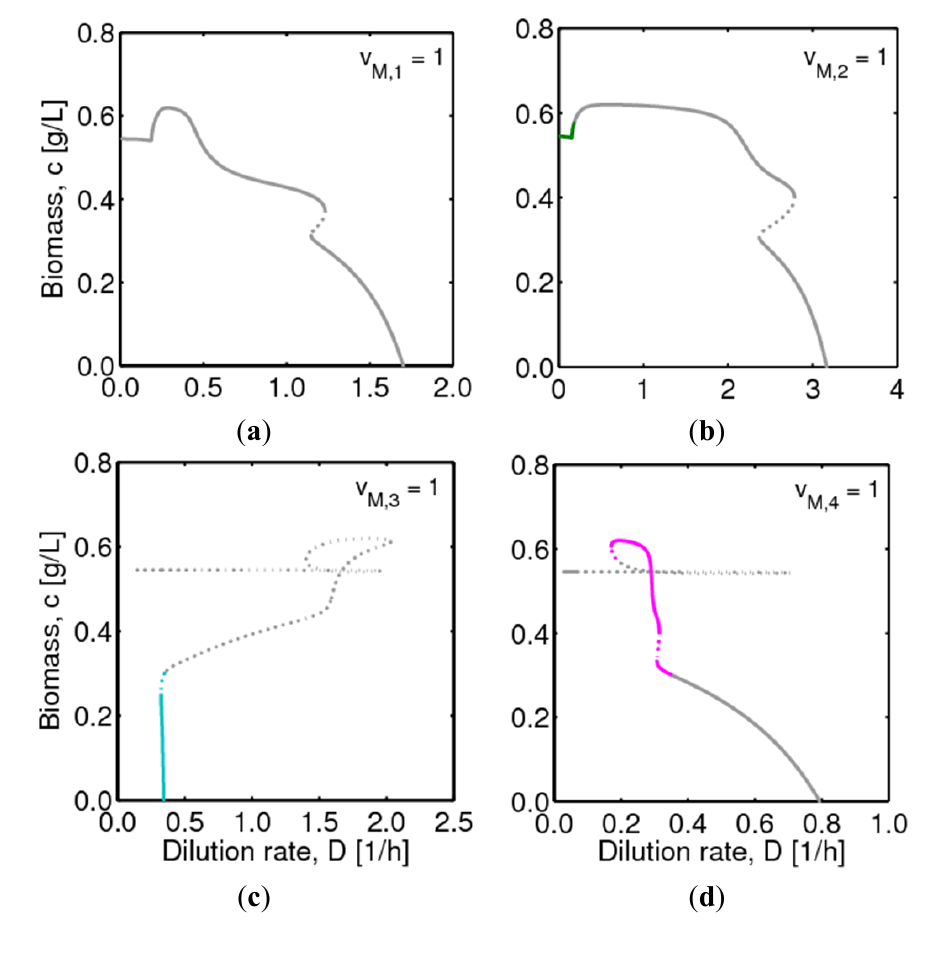
Figure 1. Hysteresis curves obtained from four cases considered in Table 2 ( x = 50 mM IN , total and γ = 0.2): ( a ) Case I ( v = 1), ( b ) Case II ( v = 1), ( c ) Case III ( v = 1) and ( d ) Case M ,1 M ,2 M ,3 IV ( v = 1). Solid and dotted lines indicate stable and unstable branches, while colored M ,4 and uncolored lines, feasible and infeasible branches,